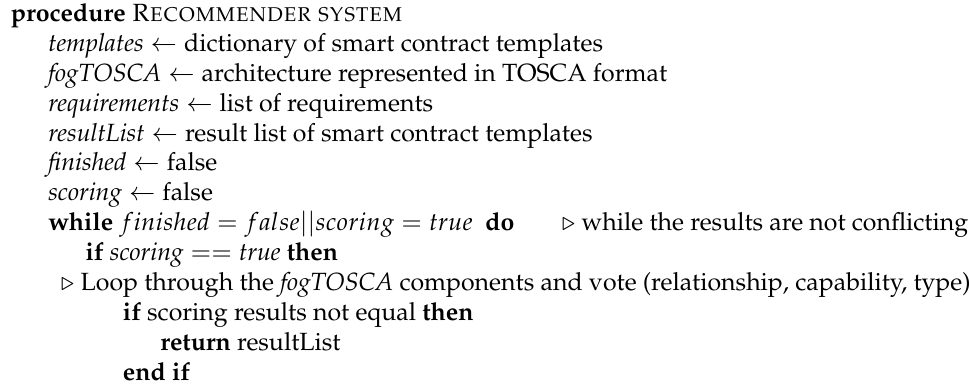
Algorithm 1 Recommender system algorithm represented in pseudocode procedure R ECOMMENDER